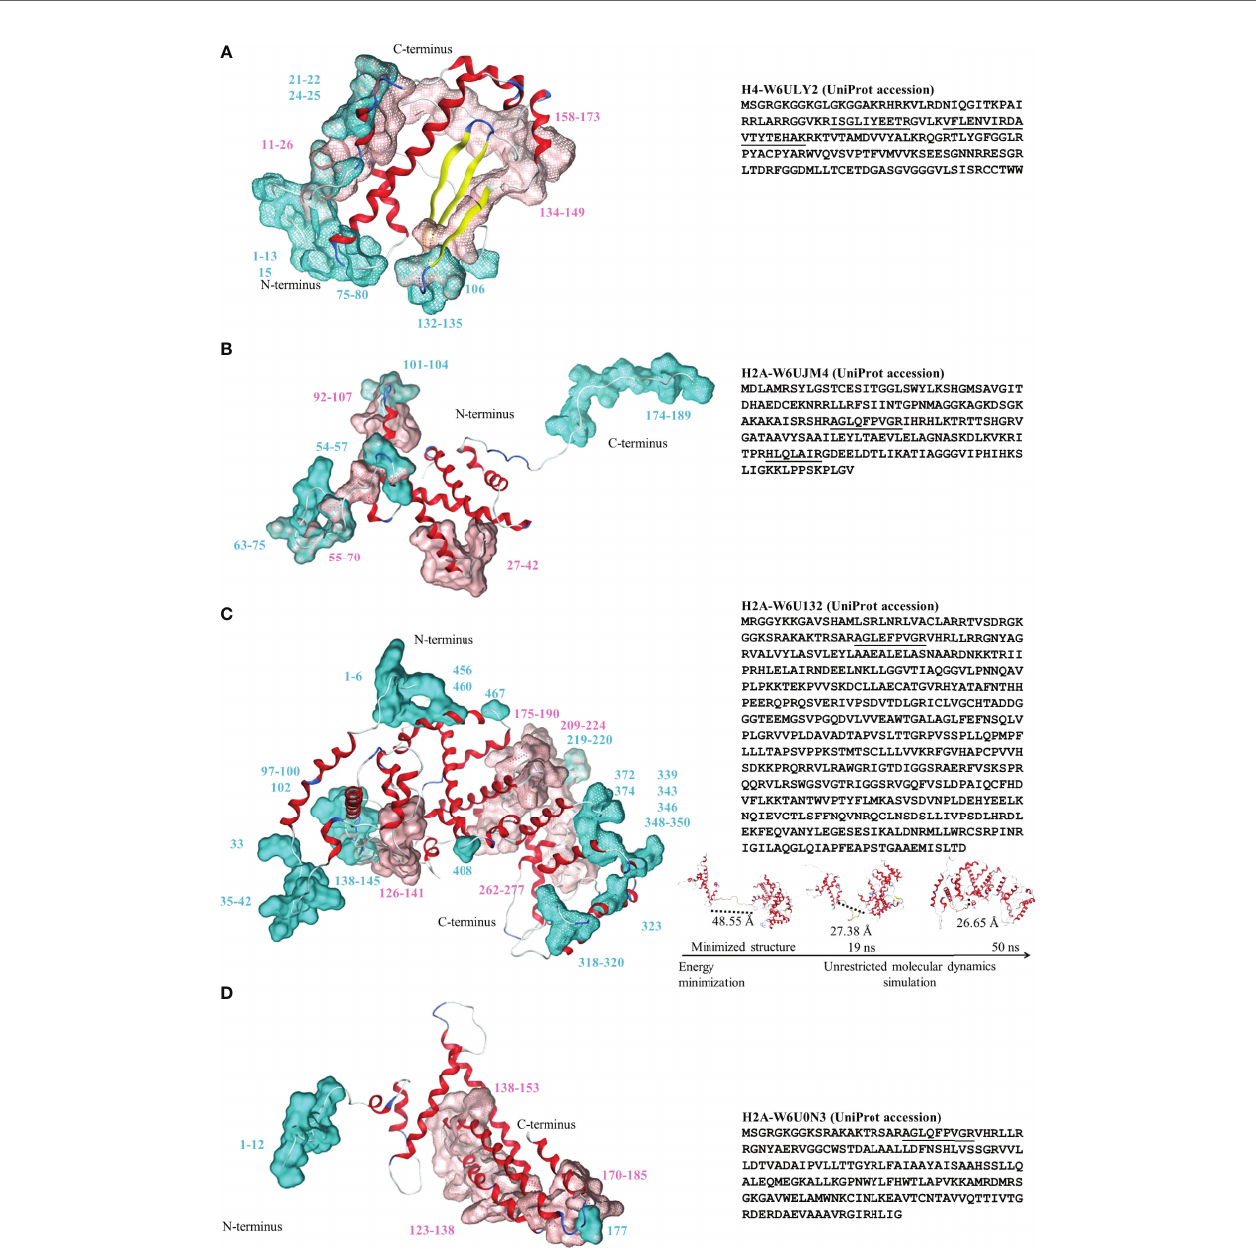
FIGURE 1 | Left: Three-dimensional structure for the histones identi fi ed by proteomic analysis. (A) Histone H4-W6ULY2, (B) Histone H2A-W6UJM4, (C) Histone H2A-W6U132, and (D) Histone H2A-W6U0N3. Conformational and linear epitopes are annotated over the three-dimensional structure by cyan and pink van der Waals surfaces, respectively. The backbone 3D structure is shown in ribbons: alpha-helices (red), beta-sheet (yellow), turns (blue) and loops (light-blue). Right: the corresponding sequences in one-letter code for the four studied histones. The peptides identi fi ed by MS/MS are underlined. For the special case of H2A-W6U132 ( C , right, bottom), snapshots of the structural conformation after the energy minimization/molecular dynamics steps are shown and dotted lines shown the loop distances between the histone and the WGR-PARP